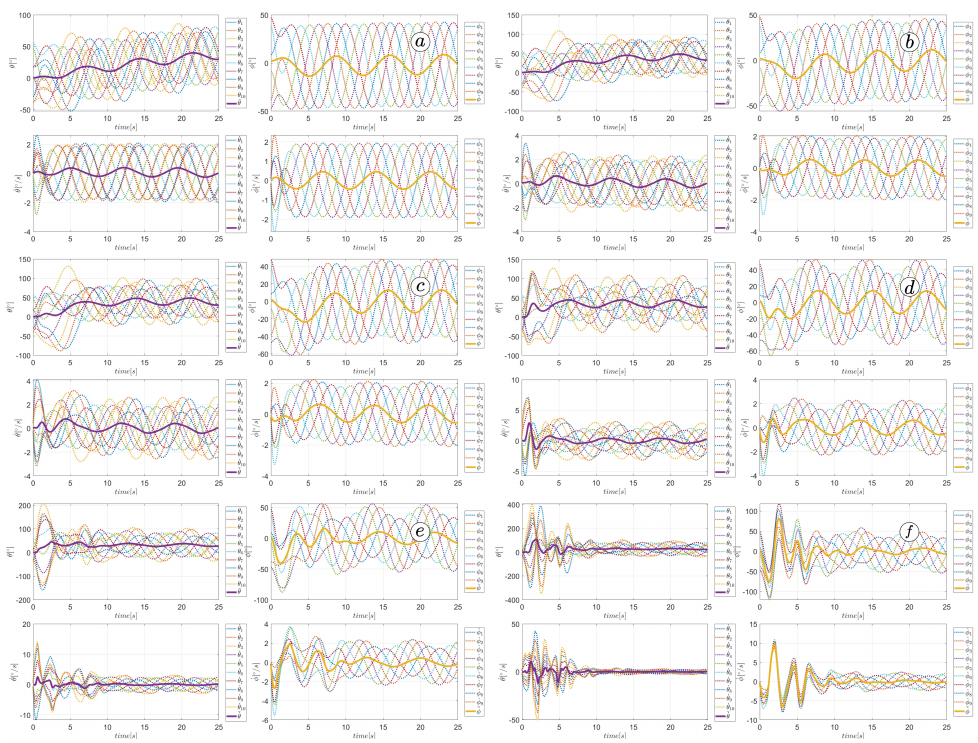
Figure 43. Values of link angles θ , joint angles φ , link angles derivatives ˙ θ , joint angles derivatives ˙ φ for k θ = 0.1 ( a ), k θ = 0.3 ( b ), k θ = 0.5 ( c ), k θ = 1 ( d ), k θ = 2 ( e ), and k θ = 3 ( f